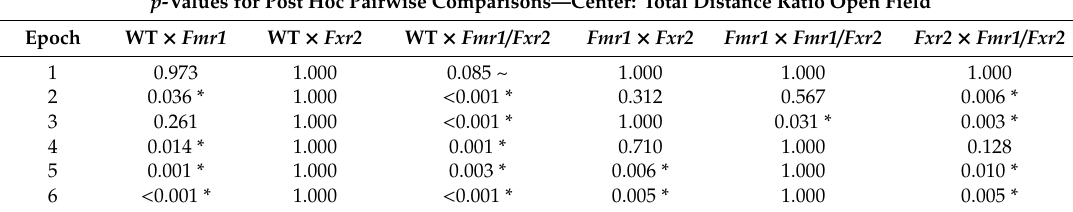
Table 2. Results of post-hoc t -tests, Bonferroni corrected, following statistically significant genotype × epoch interaction in the ratio of center distance to total distance in the open field. *, p < 0.05. ~, 0.05 ≤ p ≤